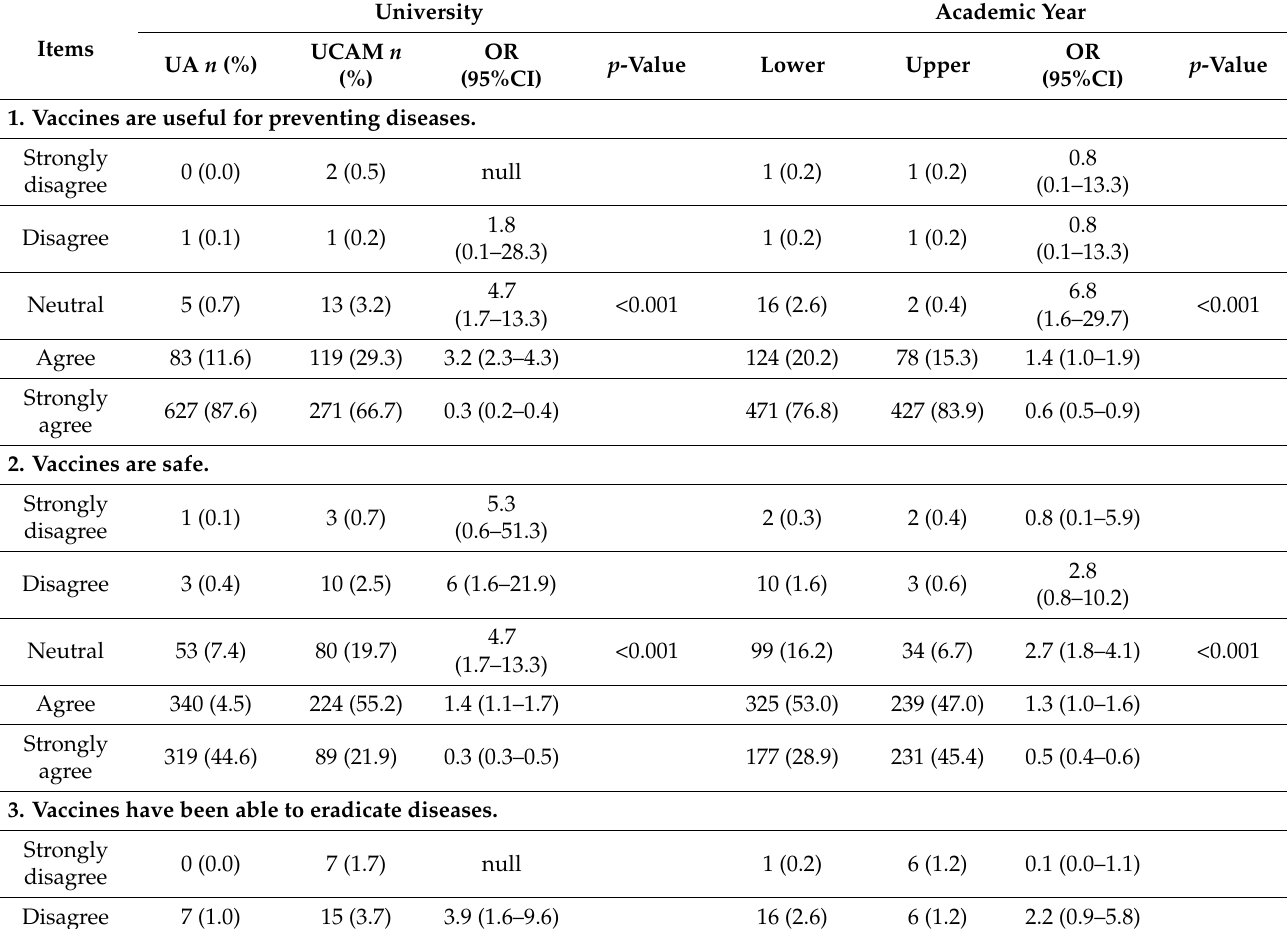
Table 4. Vaccine knowledge questionnaire score